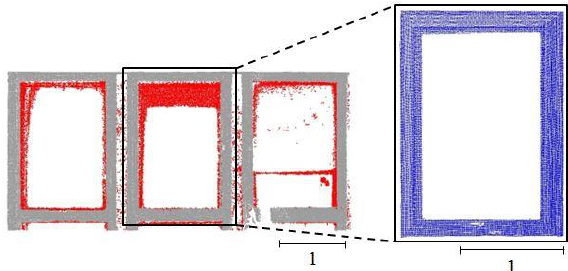
Figure 6. Result of window extraction based on